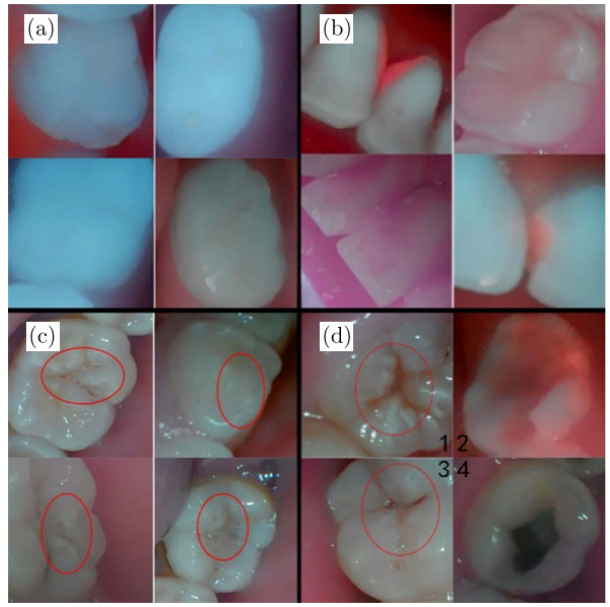
Fig. 3. The picture of test results. (a) Healthy tooth, (b) detected plaque, (c) white spot lesions, (d) severely